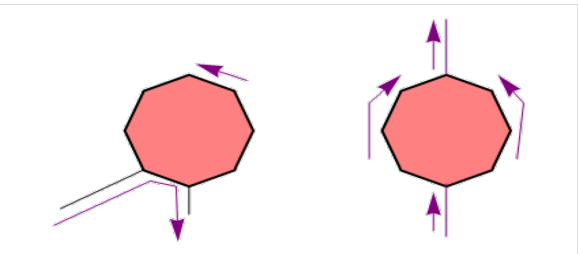
Figure 1: Left: Lateral connection of a quantum ring ( N ring = 8) to external wires (any even number of sides greater or equal than four can be considered, since the graph is bipartite, see below.) The flow of a current in the external wire selects a chirality in the ring and produces a magnetic moment. Right: a symmetric connection to the external wire. No magnetic moment is produced.